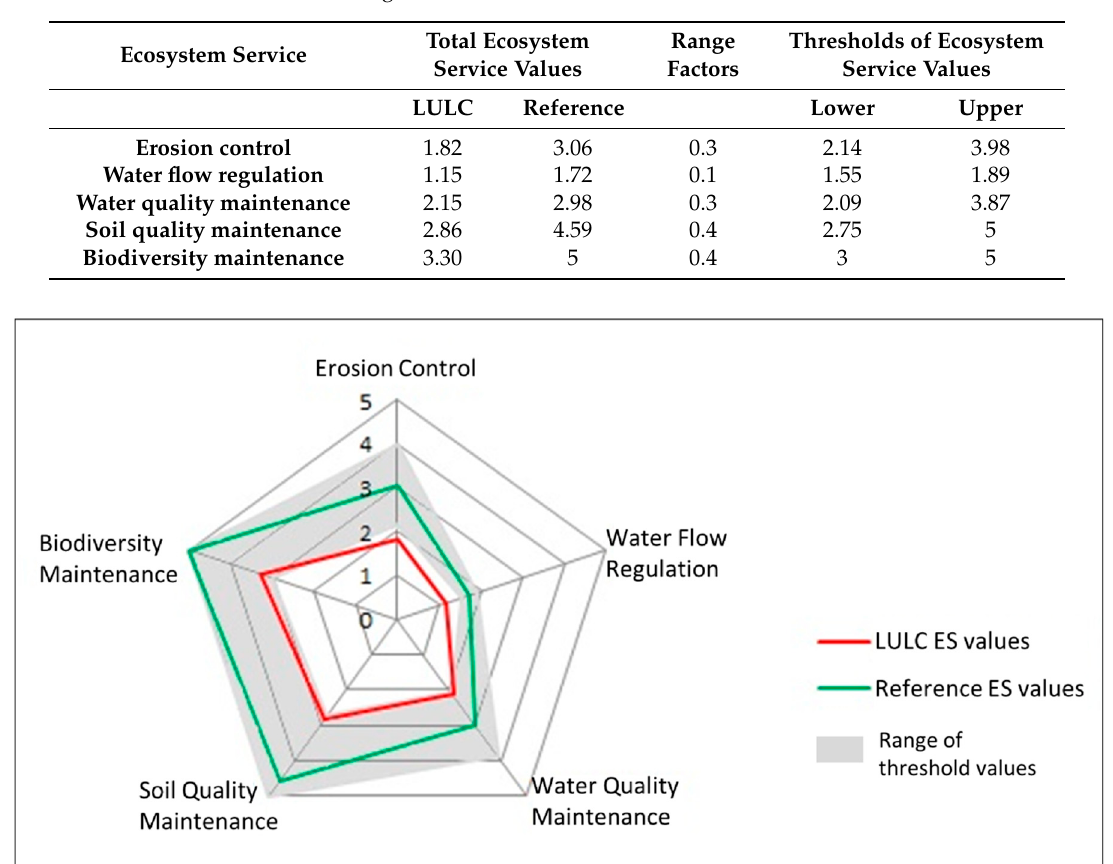
Table 4. Total ecosystem service values for the LULC and reference situations, range factors, and the calculated lower and upper threshold values for each ecosystem service. The lower and upper threshold values indicate the range of threshold values for the reference situation.